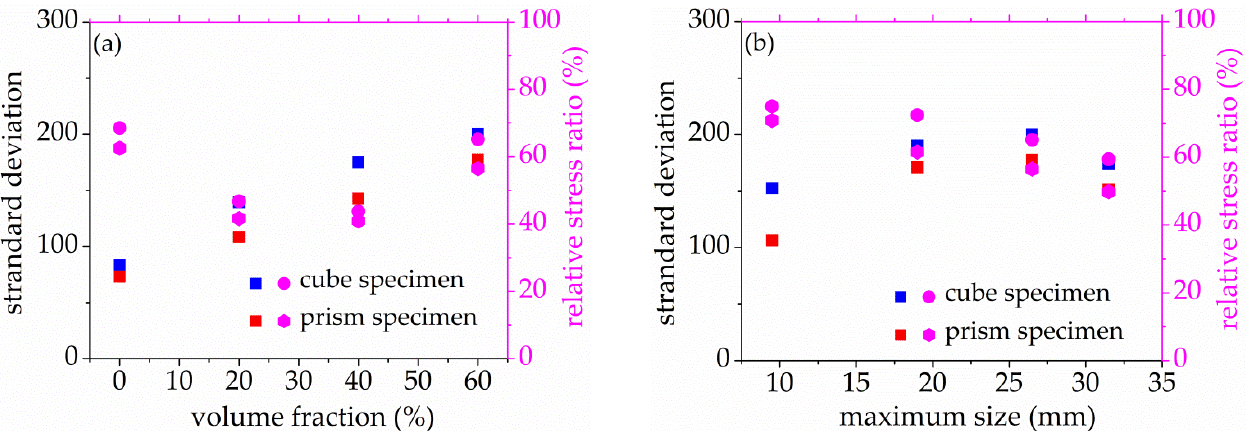
Figure 19. Standard deviation of acoustic emission penetrating wave velocity of concrete with different mix proportion at the turning point, ( a ) volume fraction, ( b ) maximum size.